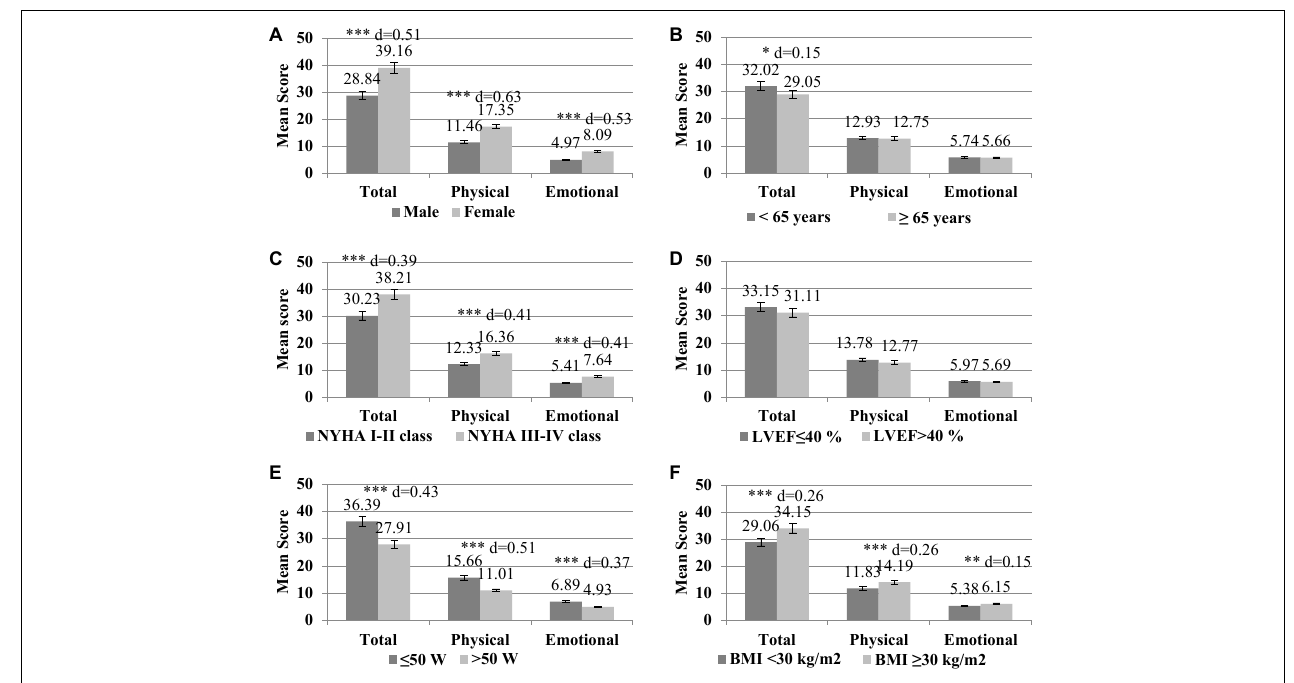
FIGURE 1 | The differences of mean scores of the Minnesota living with heart failure questionnaire (MLHFQ) dimensions (global, physical, and emotional health) according to gender (A) , age (B) , New York Heart Association, NYHA functional class (C) , left ventricular ejection fraction, LVEF (D) , watts for exercise capacity (E) , and body mass index and BMI (F) . Effect size (D) for the difference between the groups. ( ∗ p < 0.05; ∗∗ p < 0.01; ∗∗∗ p < 0.001; d, Cohen’s d effect